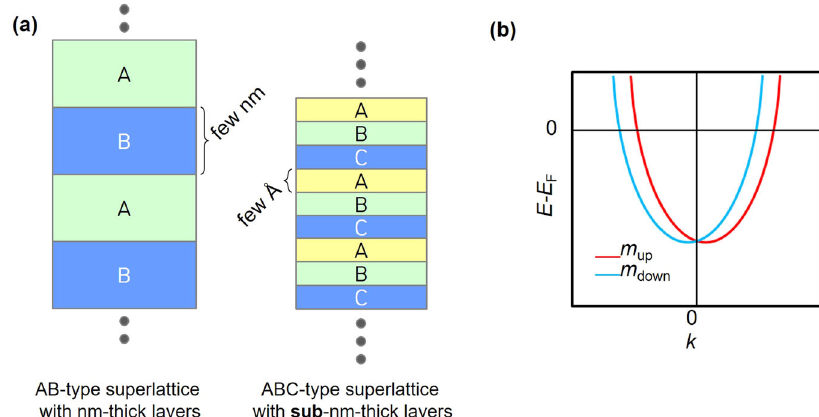
Fig. 1 SL structure with symmetry breaking in stacking order. a SLs with AB-type and ABC-type stacking-order, which is composed of nm-thick and sub-nm-thick layers, respectively. b Schematic image of an asymmetric band structure in terms of direction of magnetization in the SL with ABC-stacking